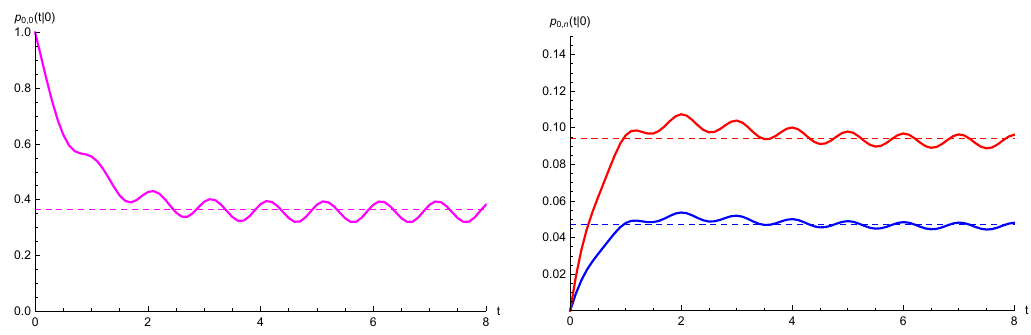
(dashed line). On the right: p − 1 ( t | 0 ) (blue 0 and p ∗ (dashed lines), given in (30). 1 1